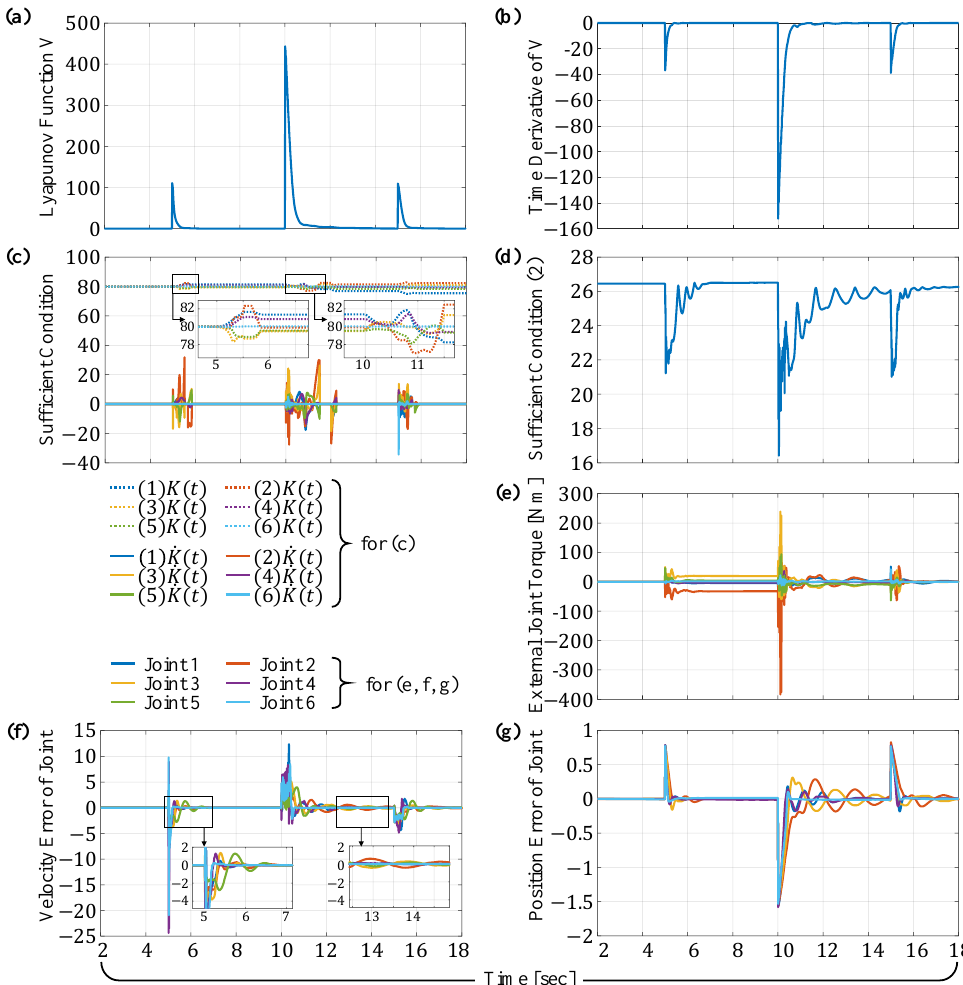
Figure 5. Simulation data while performing the simulation suggested in Figure 4; ( a ) Lyapunov function value of Equation (14) with α = 0.75, where it was designed using kinetic plus potential energies. ( b ) Time derivative of Lyapunov function of Equation (21), where we could confirm whether the closed-loop control system is being stable. ( c ) K ( t ) and ˙ K ( t ) were expressed using the proposed update rule Equation (26). ( d ) Second sufficient condition, that is, 0 of Equation (13), where we could confirm that Equation (13) was satisfied even though the impedance parameters of K ( t ) and H ( q ) (its time derivative ˙ H ( q ) ) were changed according to the joint configuration. ( e ) External joint torques obtained using Equation (7). ( f ) Velocity error of the each joint. ( g ) Position error of each